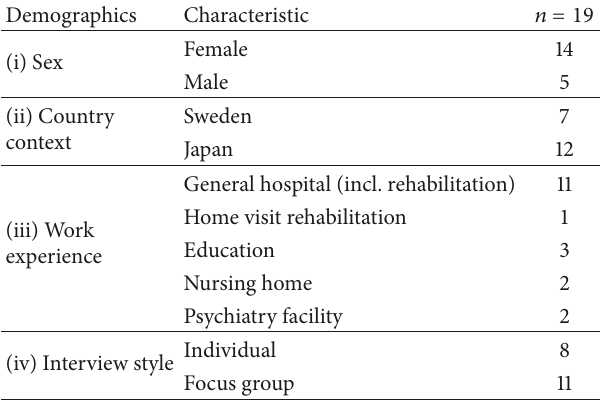
Table 1: Aggregated